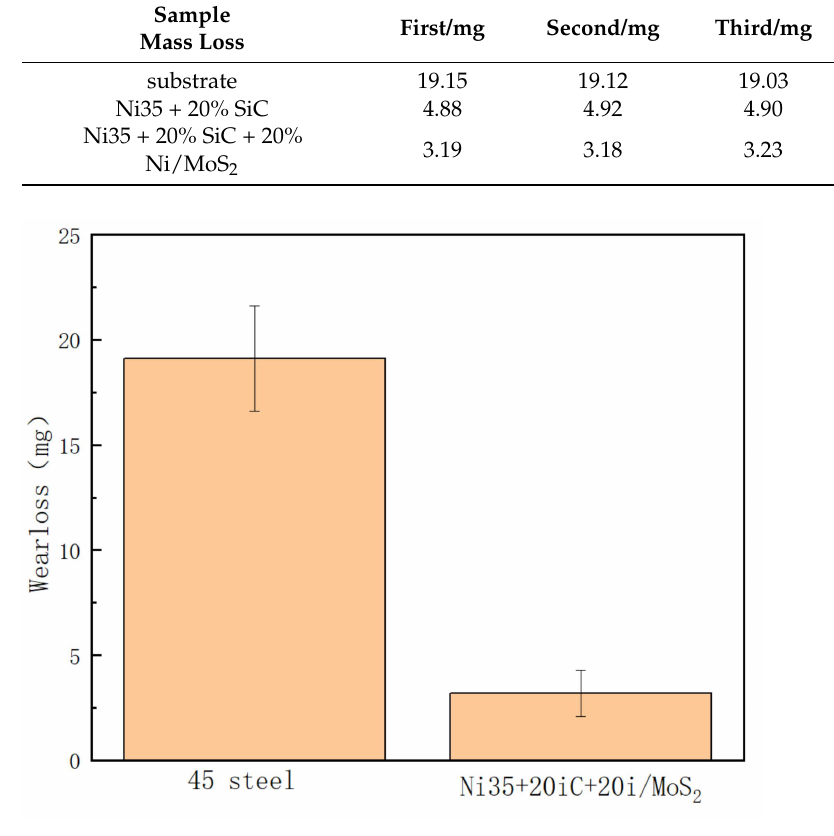
Figure 9. Mass loss of grade 45 steel and